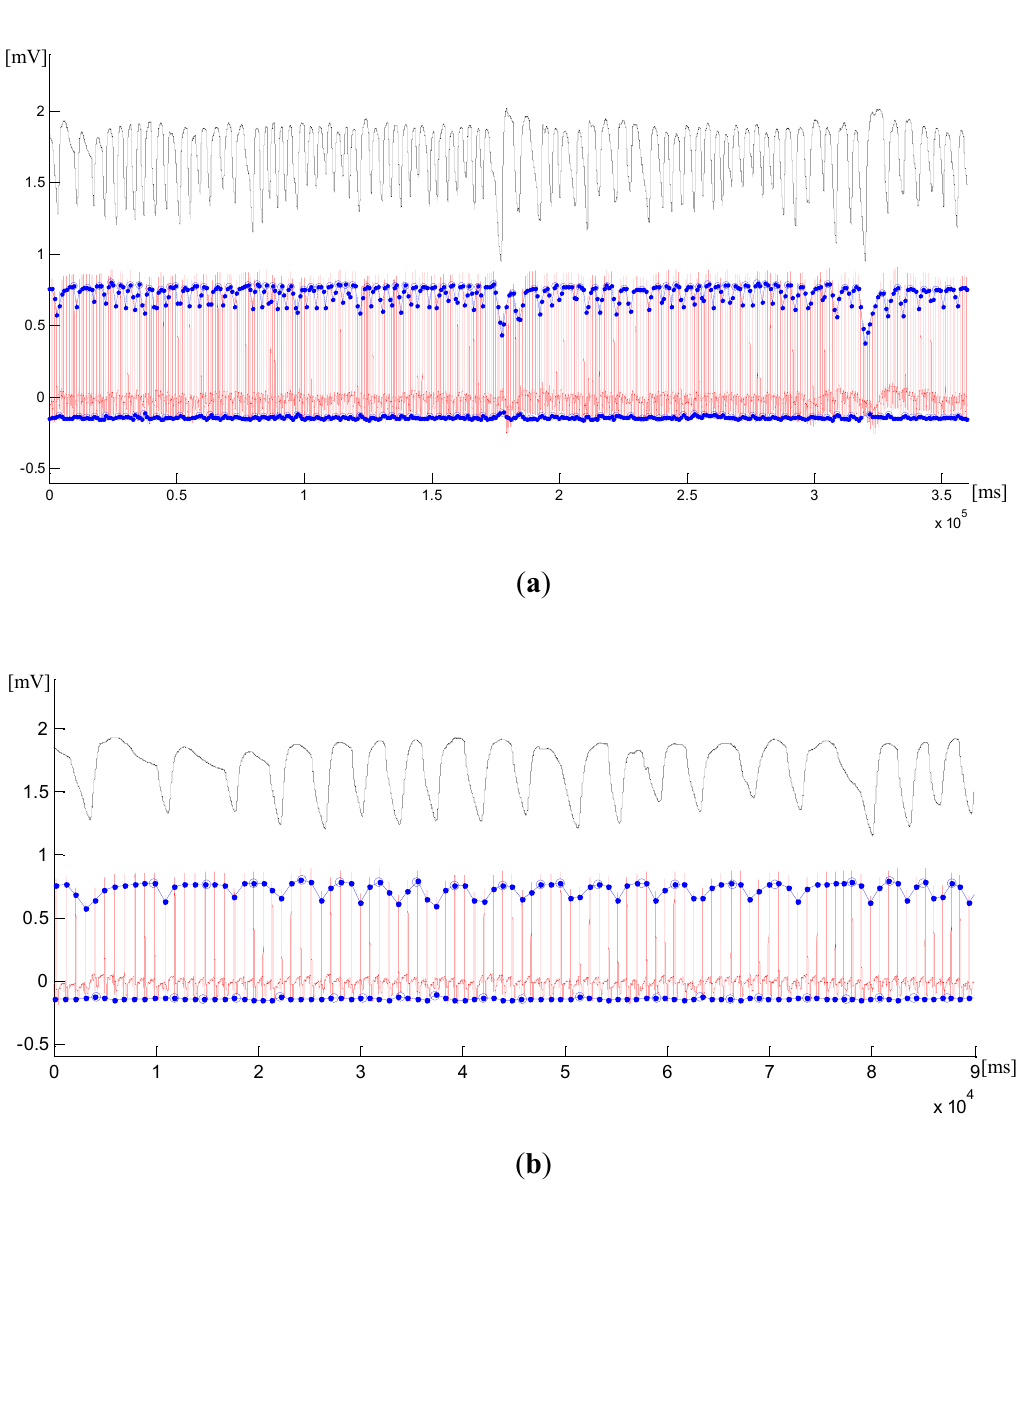
Figure 4. First measurement from the first subject case. ( a ) thermistor signal (black) with 78 RCs and (21,18) signal (red) with 385 R-peaks (blue dots) and 79 identified RCs (blue circles). ( b ) Zoomed section of the initial 90 seconds interval in (21,18). ( c ) (21,25) with 385 R-peaks and 79 identified RCs. ( d ) Zoomed section of the initial 90 seconds interval in